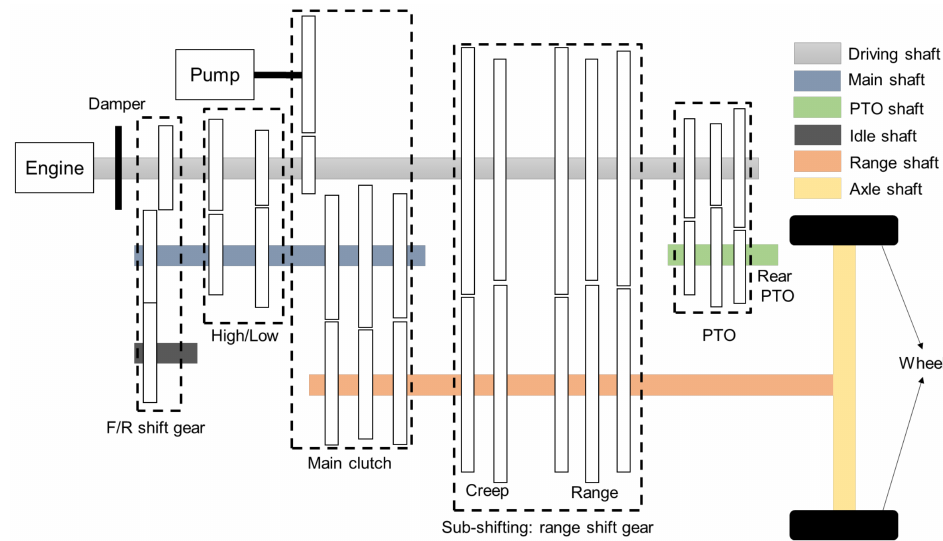
Figure 1. The schematic diagram of the PST tractor transmission.